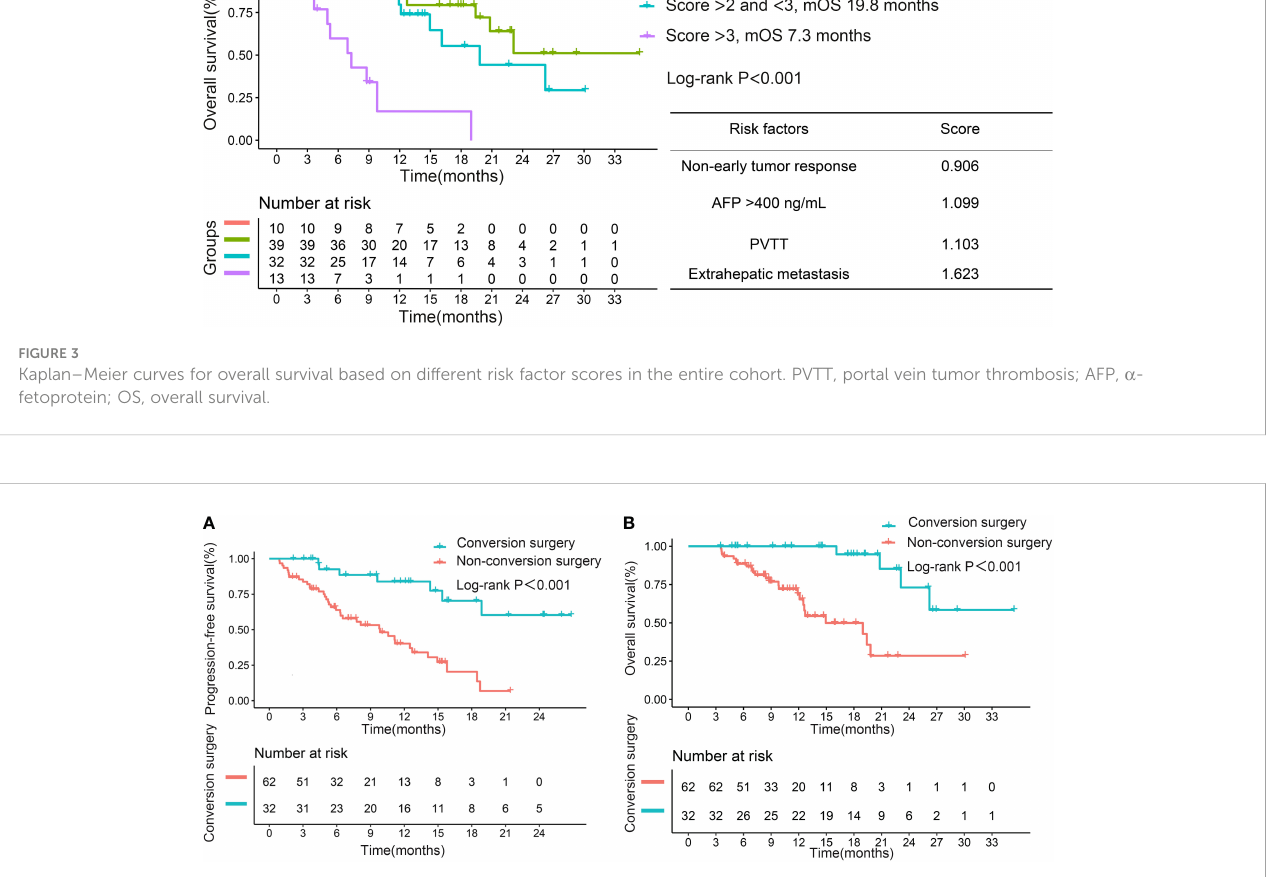
FIGURE 4 Kaplan – Meier curves for progression-free survival (A) and overall survival (B) , based on successful conversion surgery, in the entire cohort.